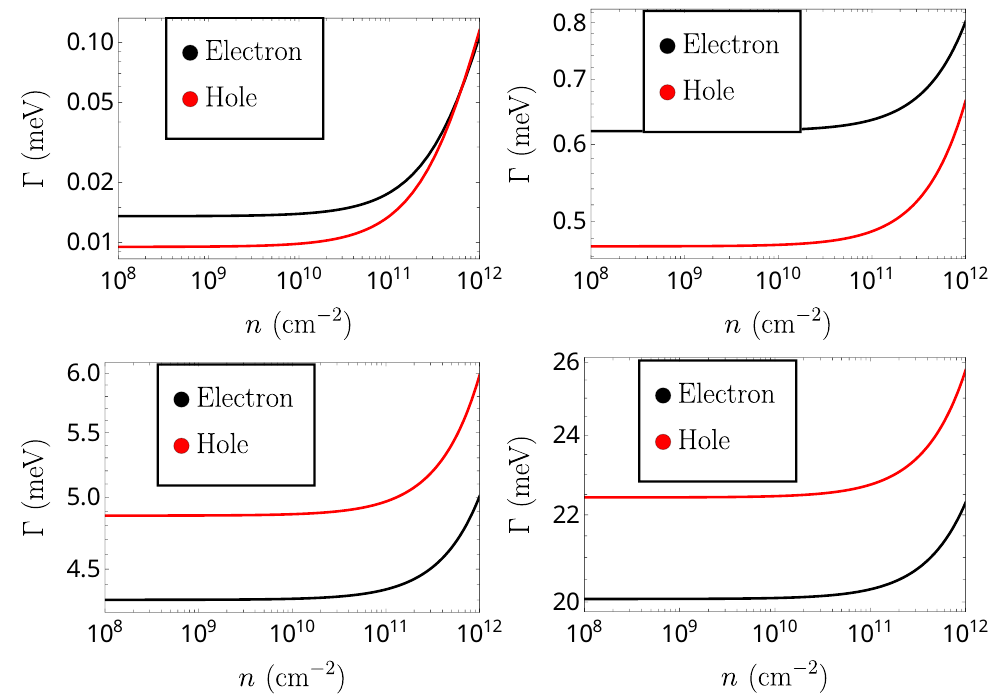
Figure 4. Contribution to exciton linewidth from scattering with free carriers as a function of the temperature at constant free carrier area density n = 10 9 cm − 2 ( left ) and n = 10 12 cm − 2 ( right ). Insets show the low–temperature region of the plot for clarity.